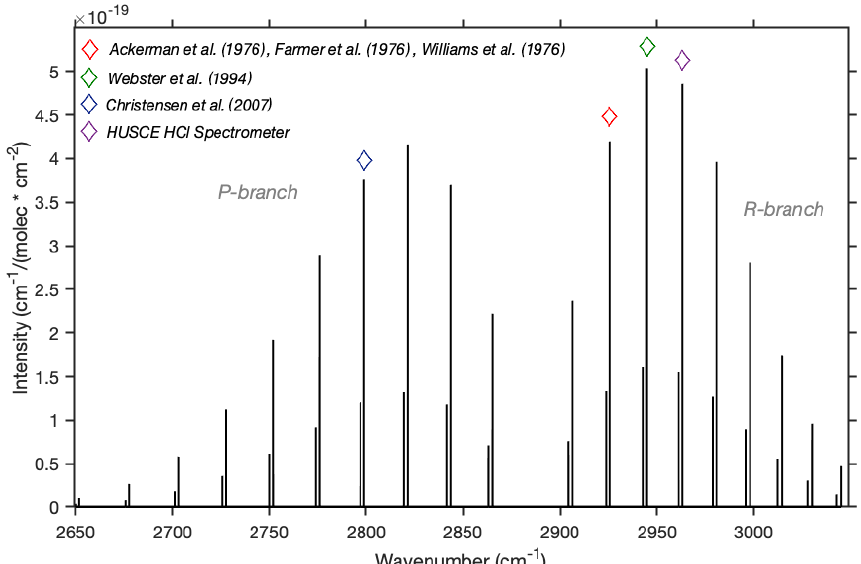
Figure 1. Line intensities of fundamental transition of HCl. The relatively smaller line that accompanies each larger line represents the transition of H 37 Cl. The purple diamond indicates the transition that the current instrument uses to measure HCl. The red, green, and blue diamonds indicate transitions utilized by past measurements of stratospheric HCl.